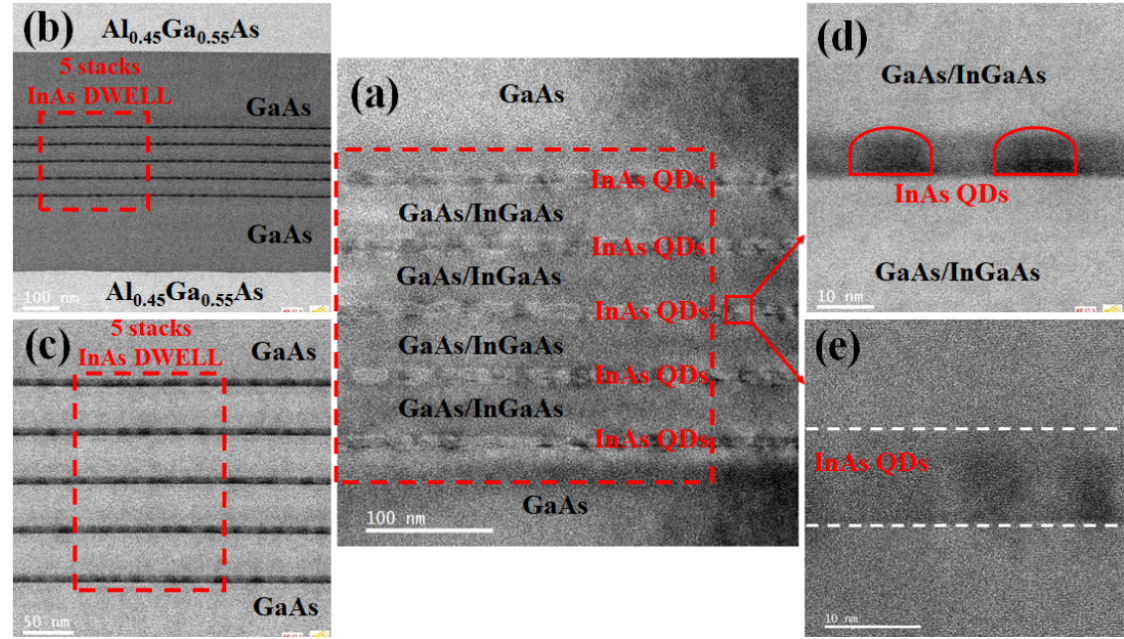
Figure 4. TEM images of the InAs/GaAs active region: ( a ) local active region; ( b ) active region with GaAs structure on both sides; ( c ) magnified image of ( b ); ( d , e ) morphology of InAs quantum dots . AFM scanning was performed on the surface of the uncapped QD structure (1 × 1 μm 2 ), as shown in Figure 5. The performance of QD devices at early stages was often lim-